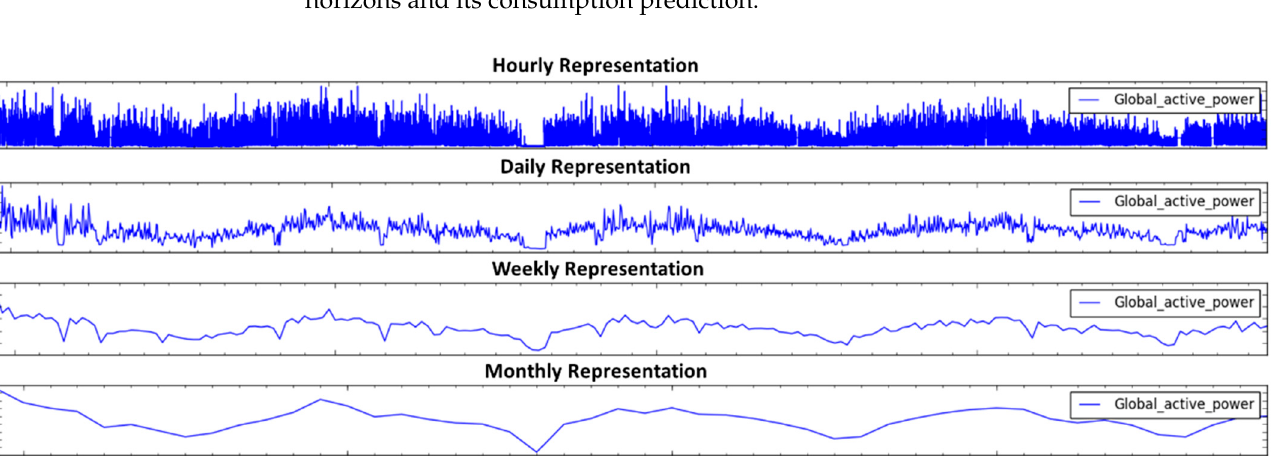
Table 6. Quantitative structure of the power consumption dataset.